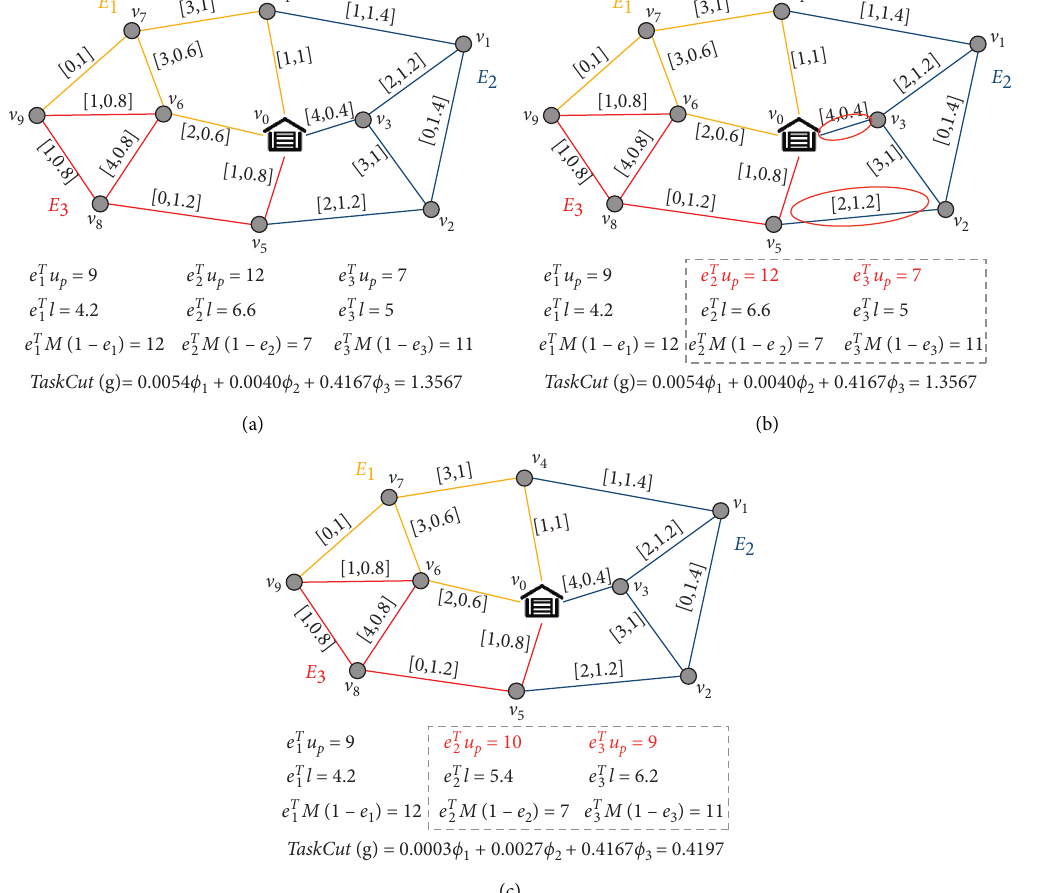
Figure 5: An illustration of the task balance operator. The first number on each edge denotes the number of underpowered e-bikes of the edge at time period p , and the second number on each edge denotes the length of the edge (km). Here, ϕ 1, respectively. (a) Existing partition. (b) Select subzones. (c) Transfer edge.